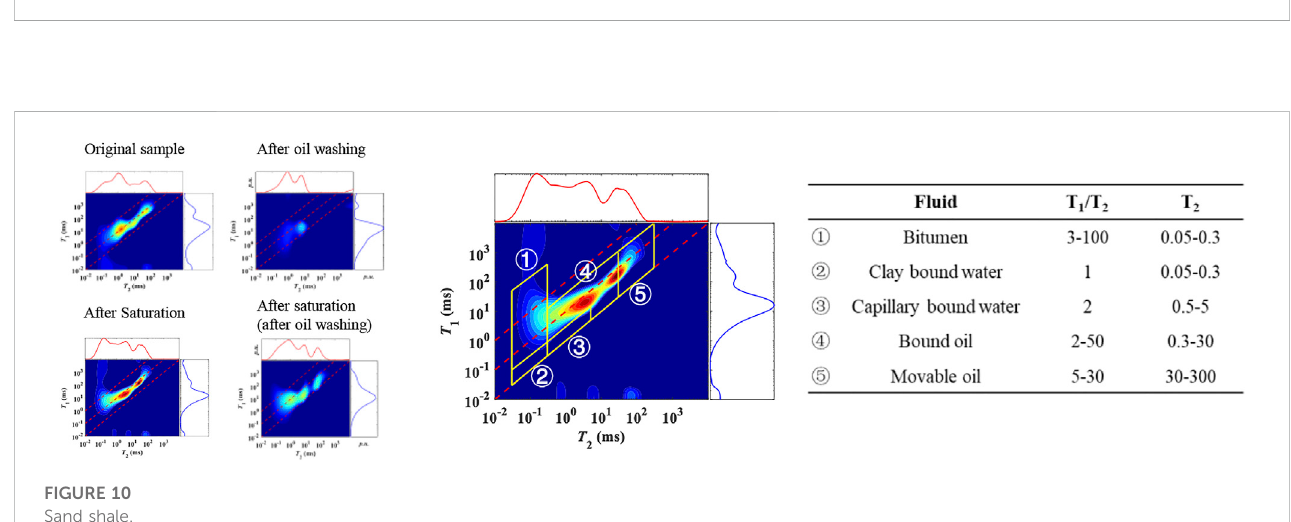
FIGURE 9 2DT 1 /T 2 NMRexperimentresultsofshalecores. (A) Originalsample; (B) Aftersaturationsample; (C) Afteroilwashingsample; (D) Aftersaturation(afteroil washing)